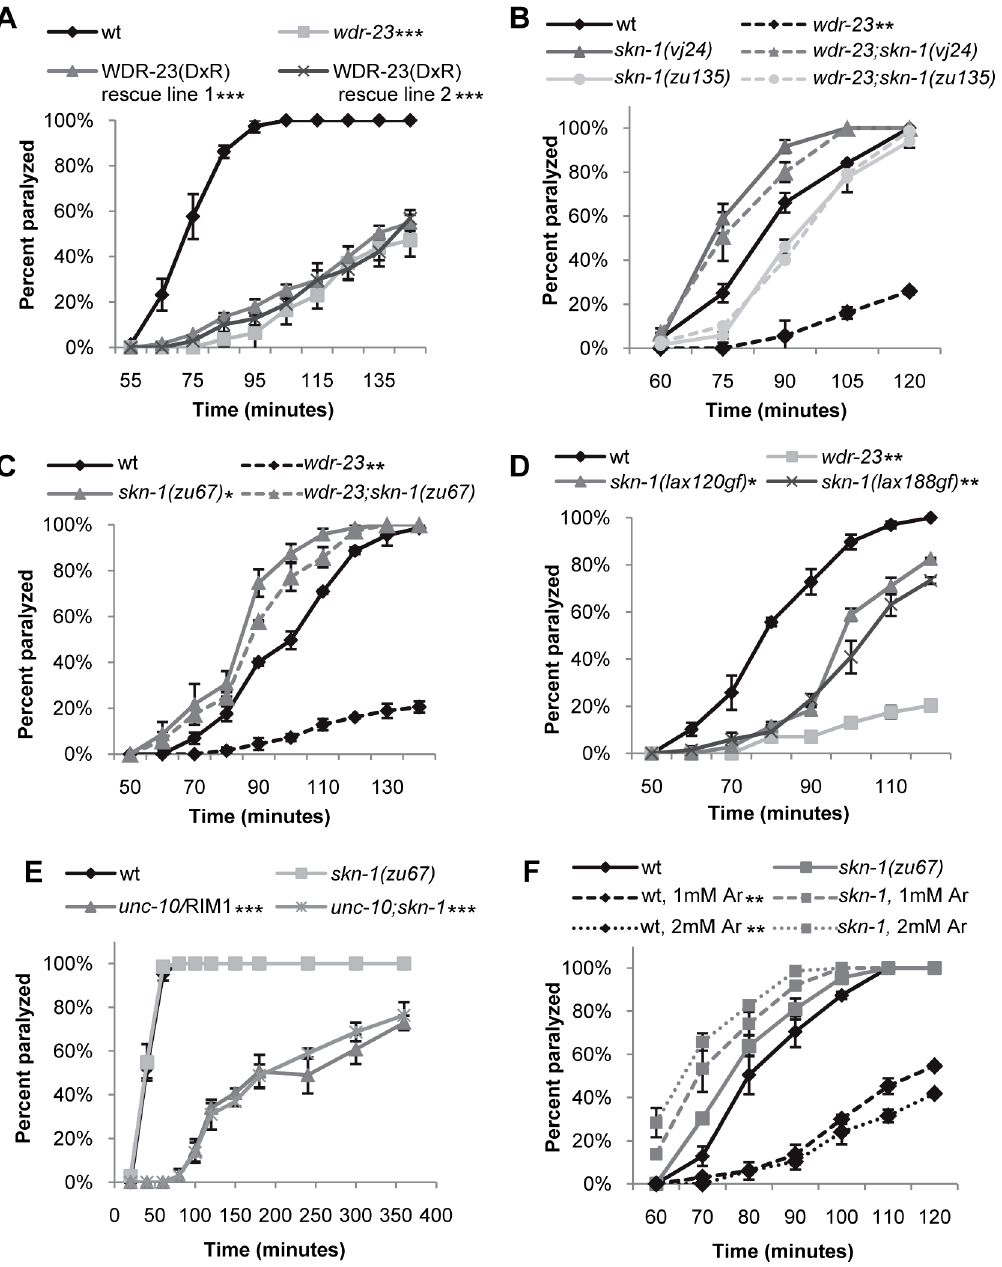
Figure 2. Loss of skn-1 suppresses the aldicarb resistance of wdr-23 mutants. Rates of worm paralysis of the indicated strains when exposed to aldicarb. (A) Expression of WDR-23(DxR) driven by the endogenous wdr-23 promoter does not rescue the aldicarb phenotype of wdr-23 mutants (1.0 mM aldicarb). (B) skn-1(vj24) encodes a R519STOP mutation, and skn-1(zu135) encodes a Q553STOP mutation. Both are in the DNA binding domain and are predicted to affect all three skn-1 isoforms. (C) skn-1(zu67) encodes a R239STOP that specifically affects skn-1a/c . (D) skn-1(gf) alleles lax188 and lax120 , which encode E237K and S245L, respectively, are resistant to aldicarb induced paralysis. (E) Loss of skn-1(zu67) does not suppress the aldicarb resistance of unc-10 mutants when exposed to 4.0 mM aldicarb. (F) Exposure to arsenite (Ar) results in skn-1- dependent resistance to aldicarb. The indicated strains were exposed to 0, 1.0, or 2.0 mM arsenite in NGM for 14 hours then allowed to recover for 3 hours prior to assay. (Error bars indicate 6 SEM. * p , 0.05, ** p , 0.01, *** p , 0.001.)